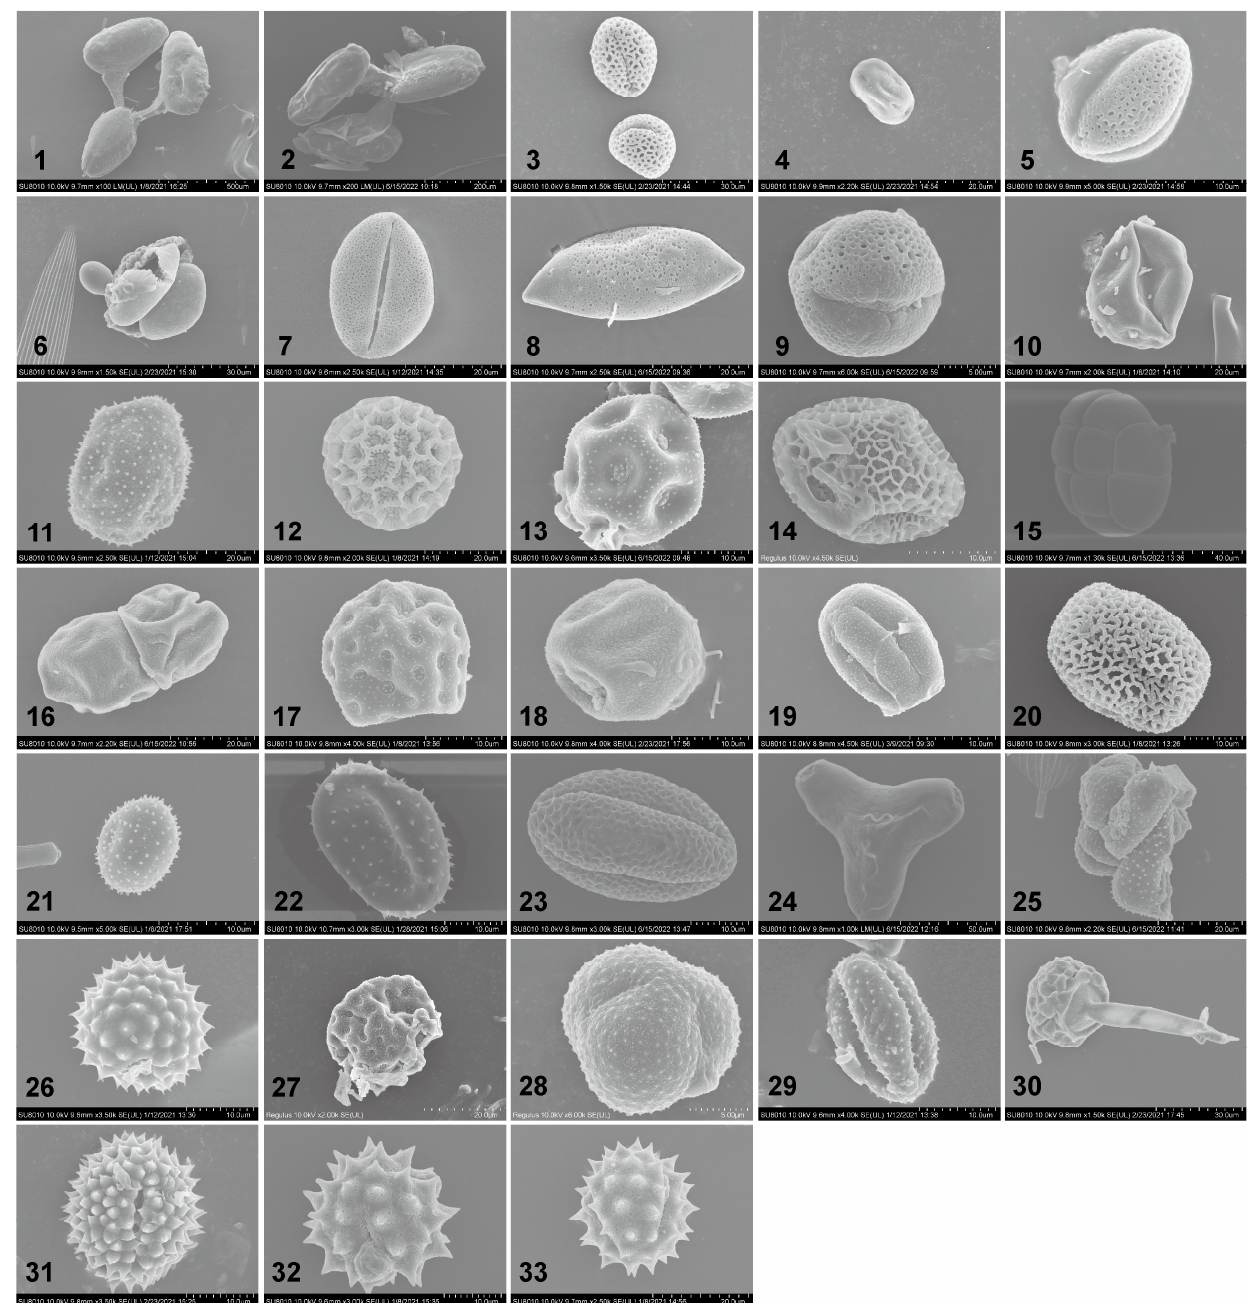
Figure 2. SEM images of the examined pollen species found adhering to Spodoptera exigua moths. 1. Cynanchum acutum ; 2. Vincetoxicum L.; 3. Ligustrum L.; 4. Melia azedarach ; 5. Brassica rapa / Brassica napus / Brassica oleracea / Brassica juncea ; 6. Pinus L.; 7. Amorpha fruticosa ; 8. Asparagus L.; 9. Flueggea suffruticosa ; 10. Solanum lycopersicum ; 11. Adenophora trachelioides ; 12. Persicaria orientalis ; 13. Gypsophila paniculata ; 14. Zanthoxylum schinifolium ; 15. Pithecellobium L.; 16. Festuca L.; 17. Suaeda glauca ; 18. Cannabis sativa ; 19. Rubia cordifolia ; 20. Cuscuta japonica ; 21. unknown; 22. Lonicera L.; 23. Fagopyrum esculentum ; 24. Oenothera L.; 25. unknown; 26. Ambrosia trifida ; 27. Chenopodium album ; 28. Artemisia annua ; 29. Artemisia L.; 30. unknown; 31. Aster tataricus ; 32. Chrysanthemum indicum ; 33. Bidens alba .